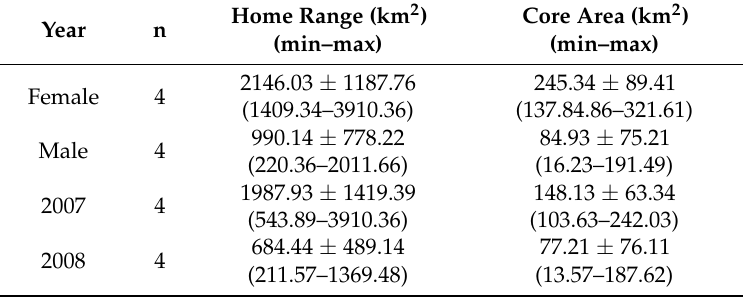
Table 2. Mean ( ± SD) home range (95% contour) and core area (50% contour) size of Bar-headed Geese (Anser indicus) marked and tracked at Qinghai Lake, during breeding seasons of 2007 and